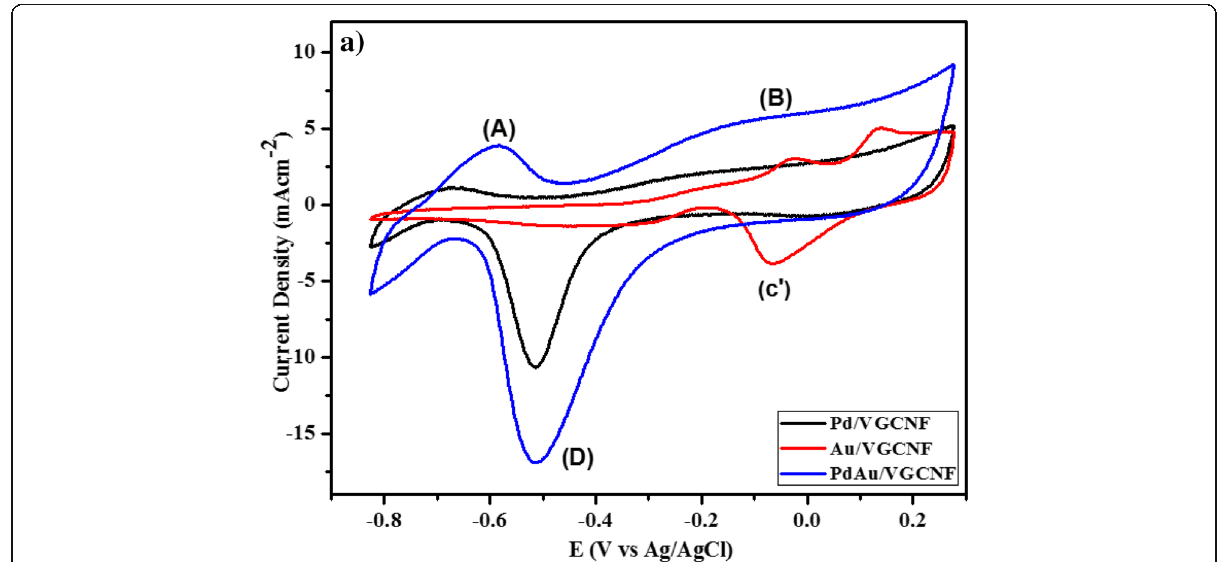
Fig. 5 Cyclic voltammogram for Pd/VGCNF, Au/VGCNF, and Pd 1 Au 1 /VGCNF in 0.5 M